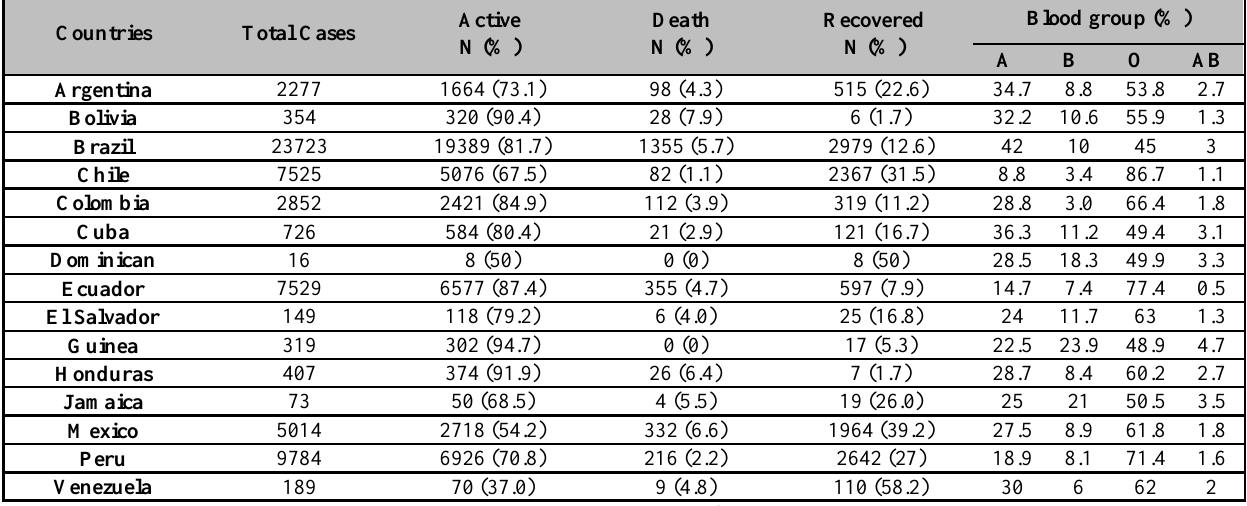
Table 4. COVID-19 in 15 Latin American Countries on the 13 th of April 2020 and the distribution of ABO blood group in these